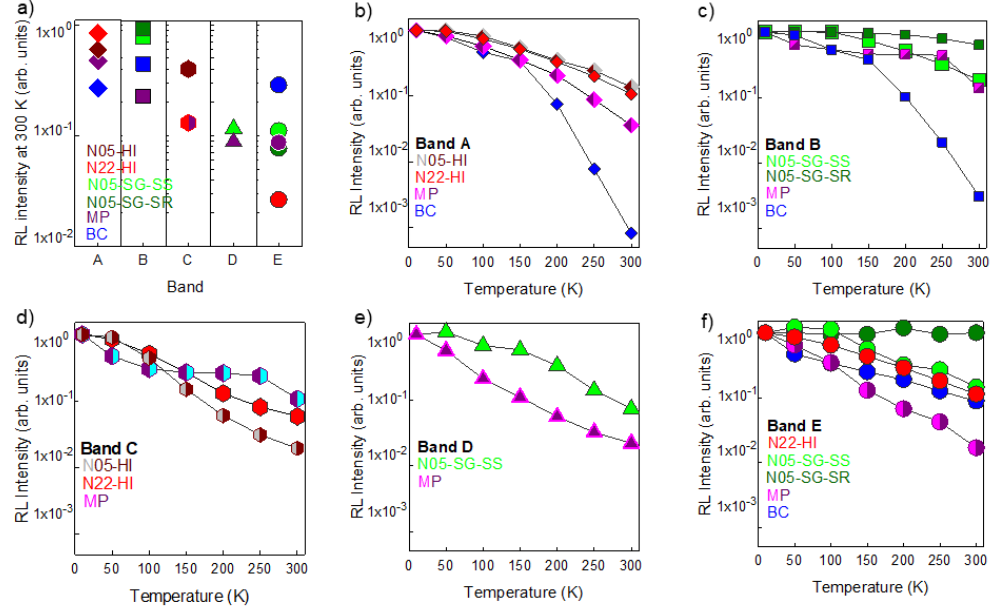
Figure 5. Temperature influence on RL spectral components of different ZnO materials: ( a ) Integrated RL intensities, displayed on a logarithmic scale, at 300 K of band A (diamond), B (square), C (hexagon), D (triangle), E (circle). For each sample, the integrated RL of a single component is normalized to the total RL intensity at 300 K. ( b – f ) Integrated RL, displayed on a logarithmic scale, versus temperature of the five spectral components. For each component, the integrated RL is normalized to its integrated RL recorded at 300 K.